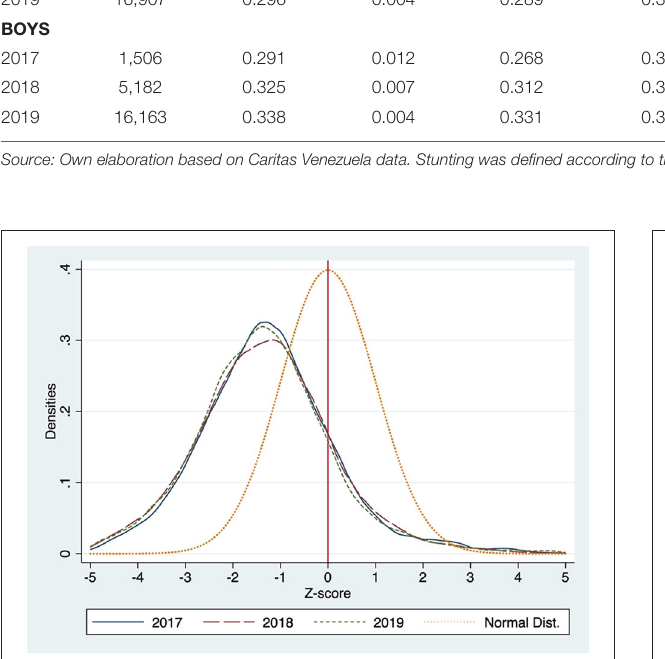
the data shows a statistically significant bias against boys until the 30th month of age. Thereafter, the gender gap dissipates.